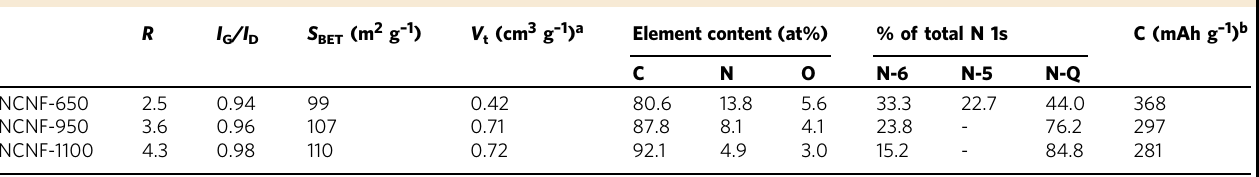
Table 1 Structure properties and surface chemistry of the NCNFs